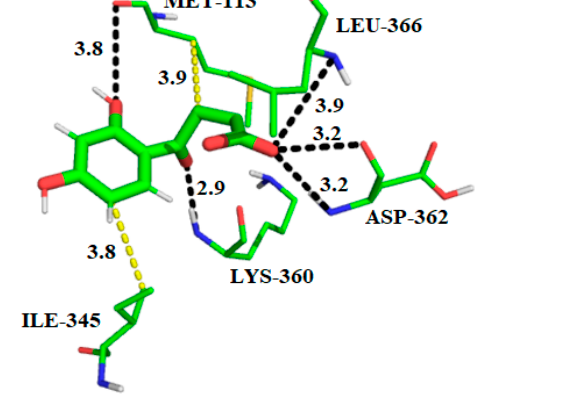
Figure 6. 3D interaction maps (distances Å) of all compounds studied with a COX-2 active binding site from 20 ns molecular dynamic simulation; ( A ) binding profile of ibuprofen, ( B ) binding profile of MBPA compound and ( C ) binding profile of DHBPA compound. The substrate site residues are depicted in lines, whereas compounds are depicted in the stick model. The hydrogen bonds are displayed as black dashed line, hydrophobic interactions are displayed as yellow dashed line and the saline bridge as a red dashed line. All distances are measured in angstroms. Stick: Green = carbon, red = oxygen and gray = hydrogen. Lines: Green = carbon, red = oxygen, gray = hydrogen and blue = oxygen. Figure was generated using the PyMOL 2.2.3 program .